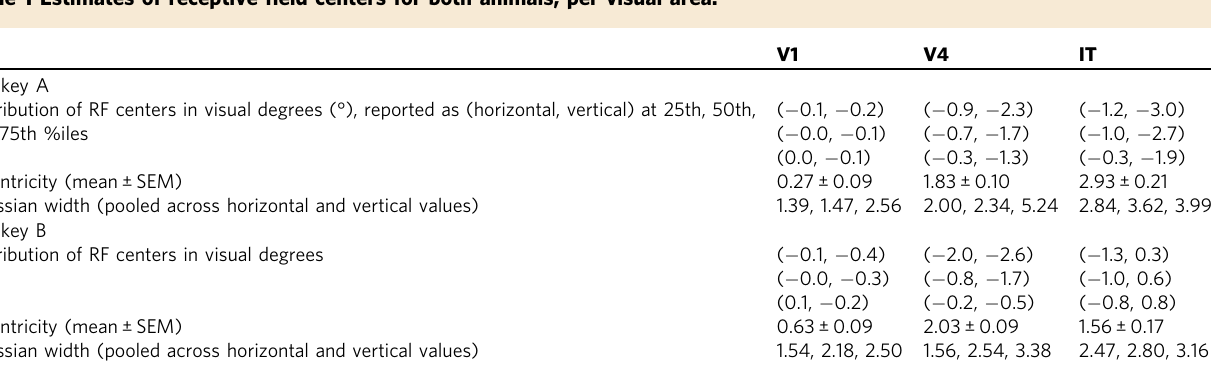
Table 1 Estimates of receptive fi eld centers for both animals, per visual